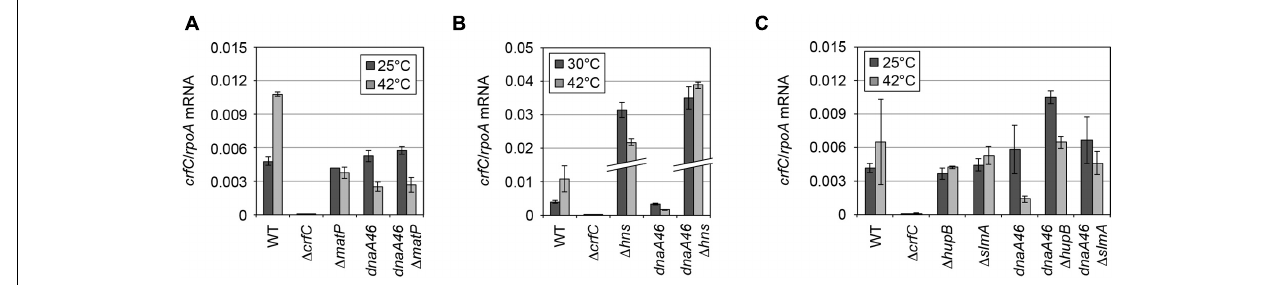
FIGURE 5 | mRNA level of crfC in mutant cells. (A) Levels of crfC mRNA in MECS145 ( (cid:49) matP ) and MECS160 ( dnaA46 (cid:49) matP ) cells. Cells were grown at 25 ◦ C (gray bars) and further incubated at 42 ◦ C for 2 h (black bars). Error bars indicate SD ( n = 2). (B) Levels of crfC mRNA in MECS171 ( (cid:49) hns ) cells and its derivatives bearing dnaA46 (MECS174). Cells were grown at 30 ◦ C (gray bars) and further incubated at 42 ◦ C for 2 h (black bars). Error bars indicate SD ( n = 2). (C) Levels of crfC mRNA in (cid:49) hupB (MECS179) or (cid:49) slmA (MECS177) cells and their derivatives bearing dnaA46 (MECS180 and MECS178, respectively). Cells were grown at 25 ◦ C (gray bars) and further incubated at 42 ◦ C for 2 h (black bars). Error bars indicate SD ( n =